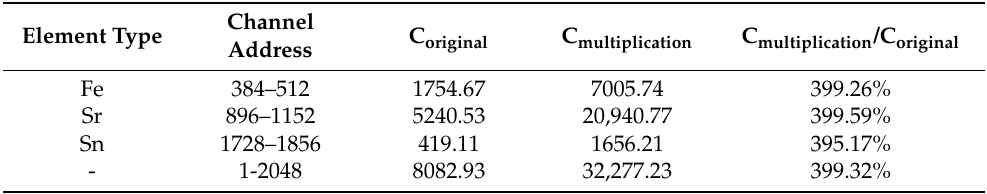
Table 1. Comparison of counting rates before and after multiplication. (Only the pulse circulation method is